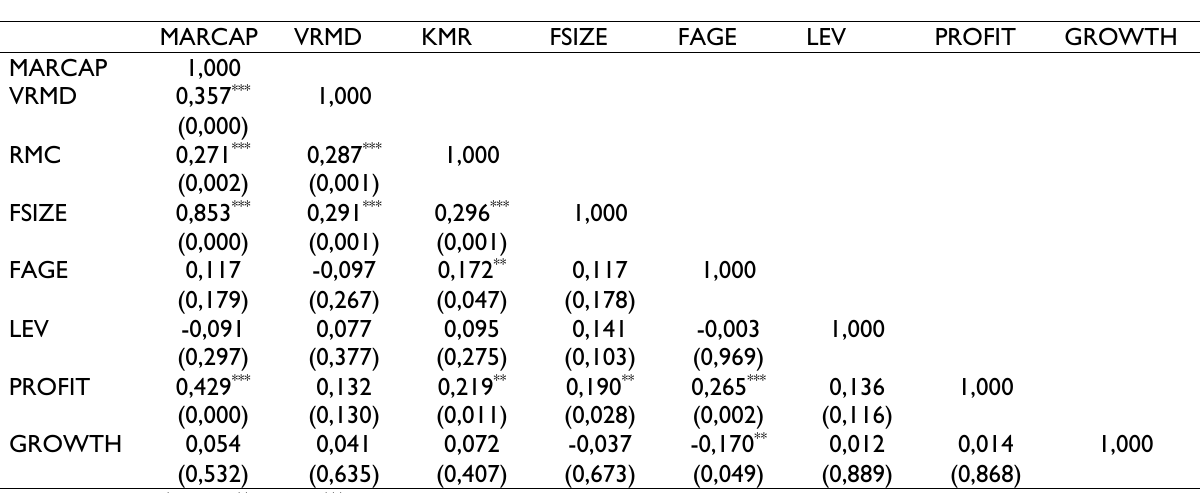
Table 3. Pearson Correlation Test